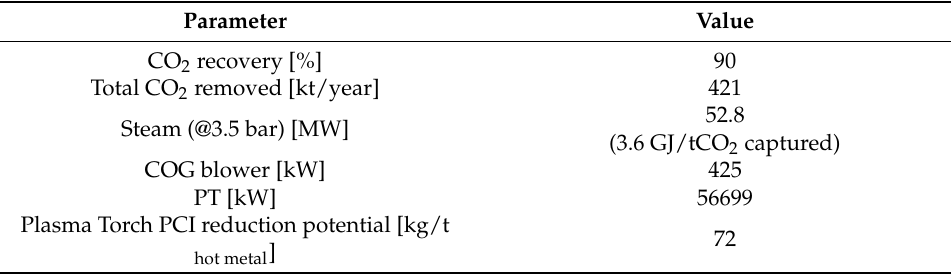
Table 7. Modelling results for the reference